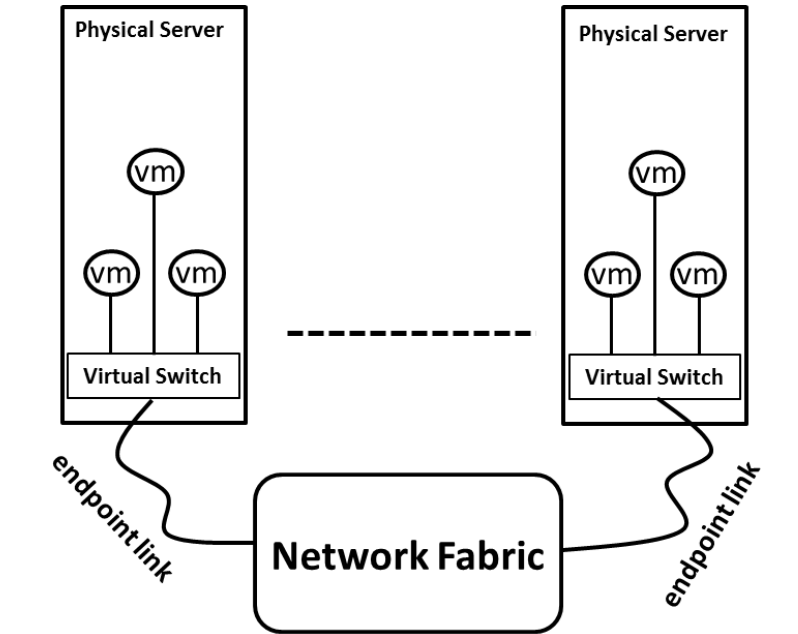
Figure 3. The IaaS-based cloud